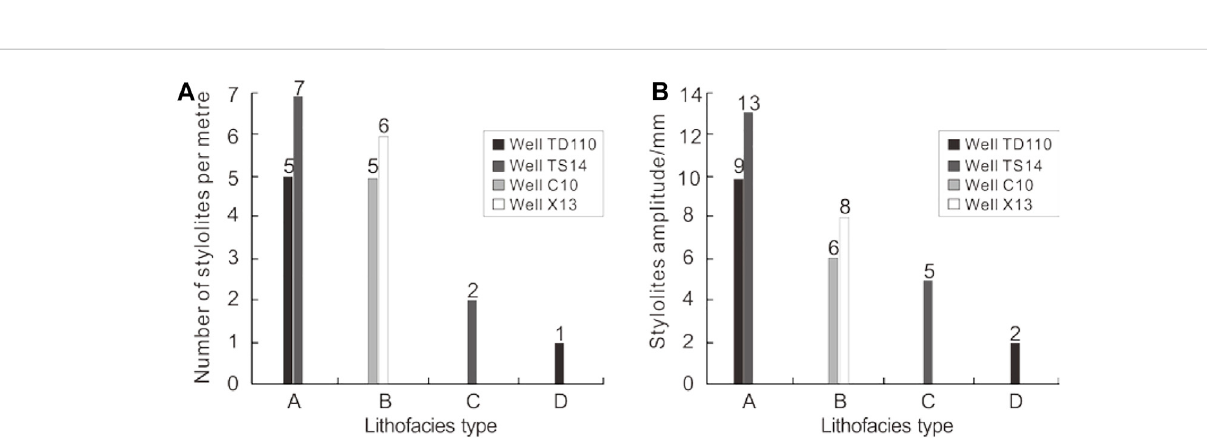
(Figure 8). Due to the barrier effect of platform-margin oolitic shoal during the deposition of T 1 f 1 – T 1 f 2 , penesaline seawater is formed by